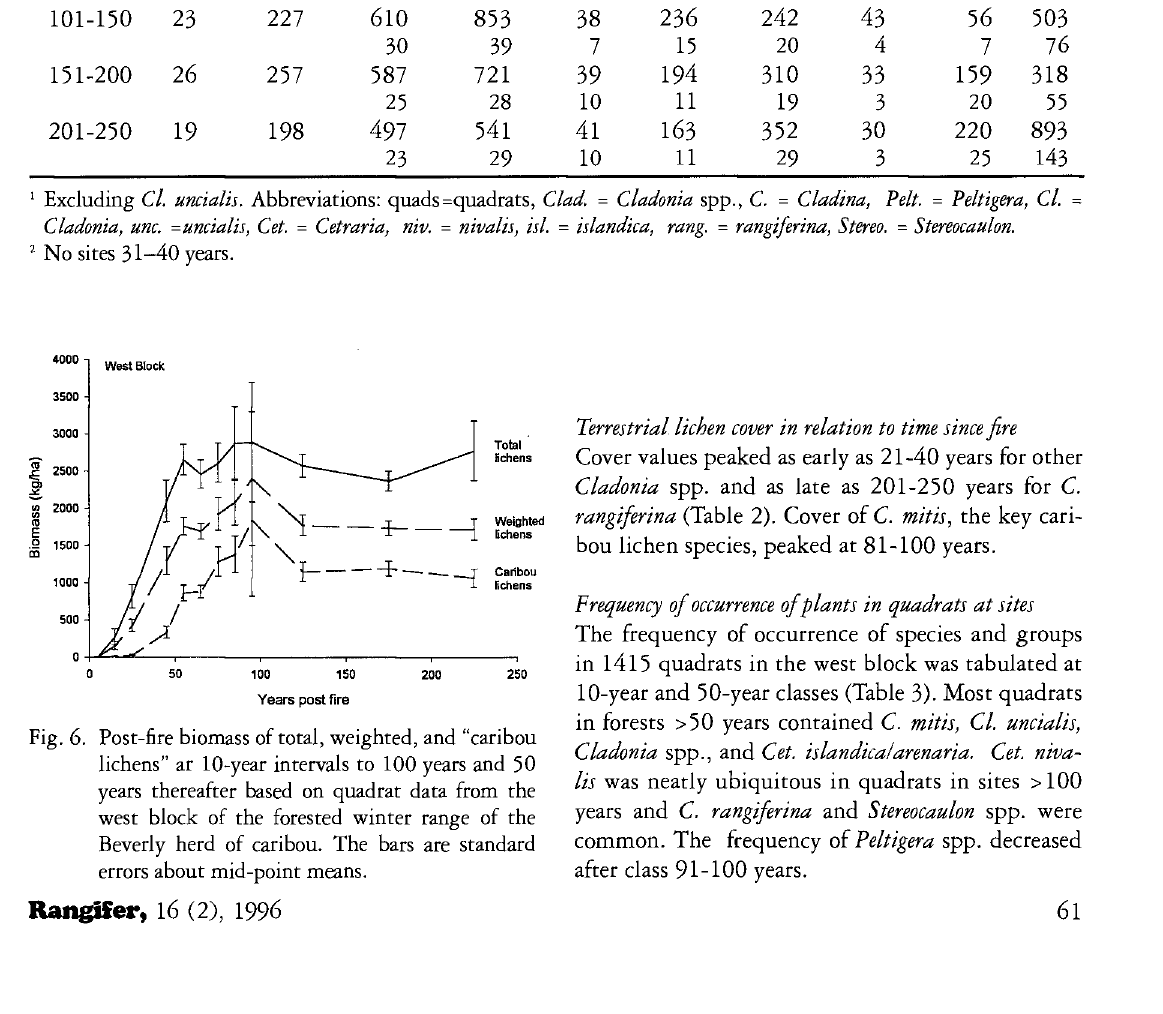
Fig. 6. Post-fire biomass of total, weighted, and "caribou lichens" ar 10-year intervals to 100 years and 50 years thereafter based on quadrat data from the west block of the forested winter range of the Beverly herd of caribou. The bars are standard errors about mid-point